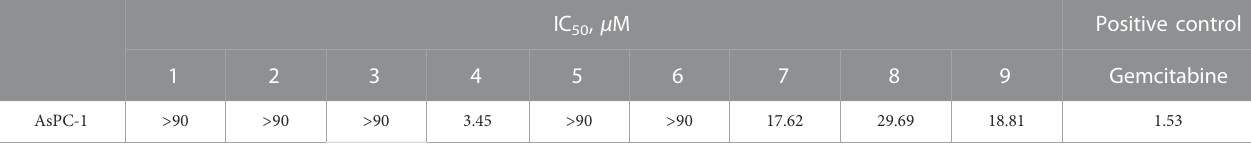
FIGURE 4 Postulated biogenetic pathway of 1 – 3 .